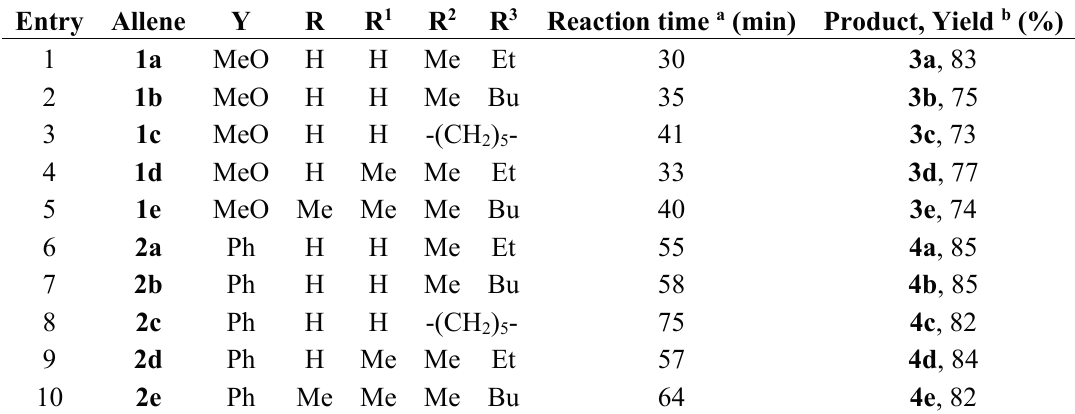
Table 3. AgClO 4 -Catalyzed cycloisomerization of the phosphorylated α -hydroxyallenes 1 and 2